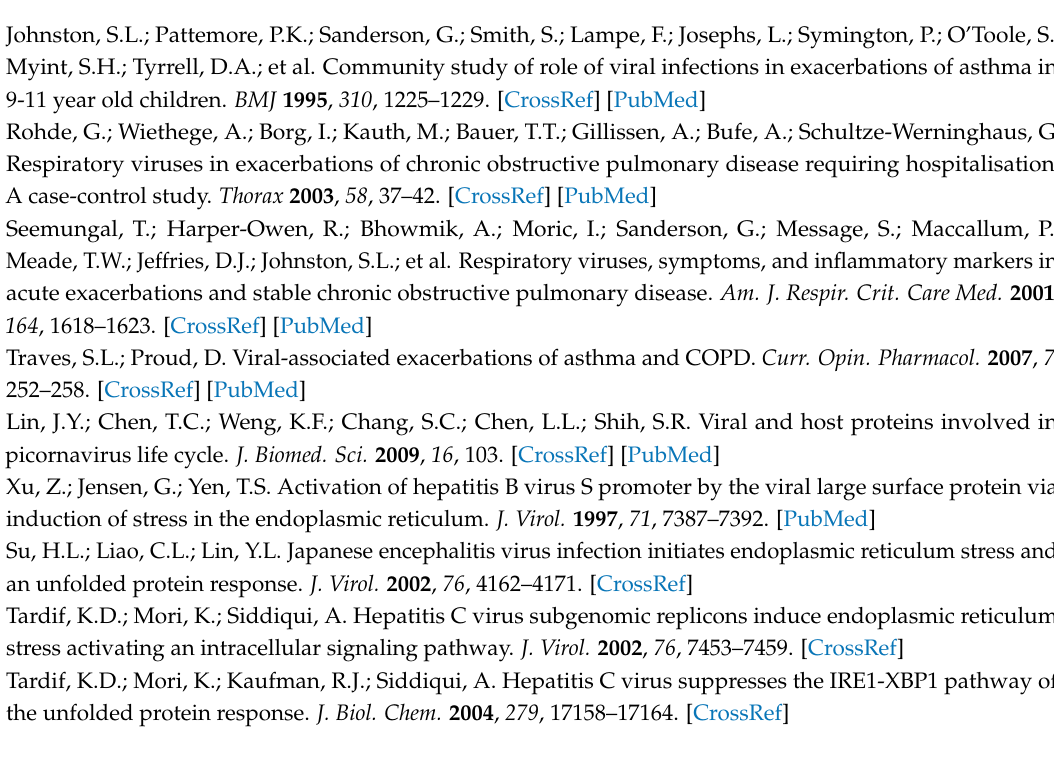
s1, Figure S1: HRV16 infection induces dephosphorylation of IRE1; Figure S2: HRV16 2B dephosphorylates p-IRE1